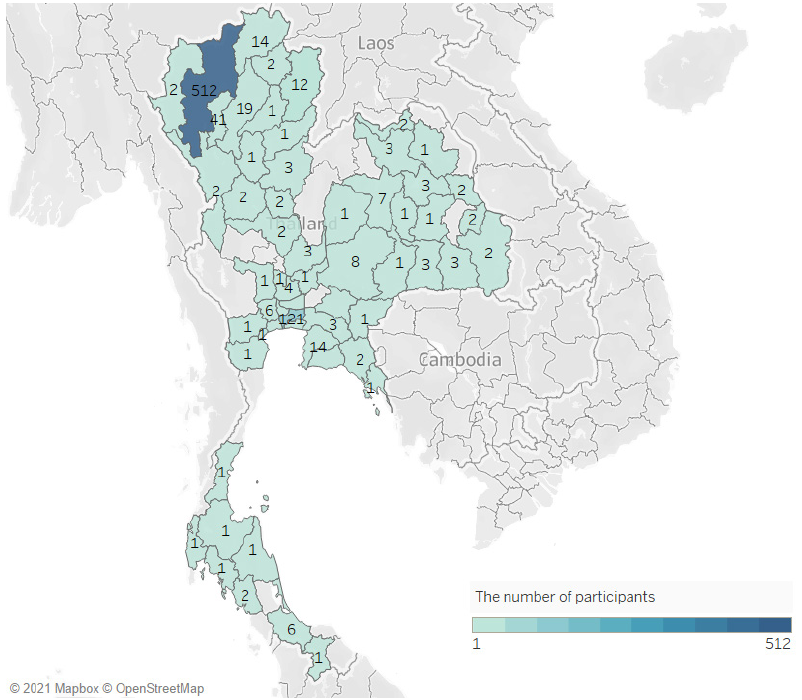
Figure 2. The distribution of survey participants. The figure was created by Tableau Desktop 2021.1, LLC, Seattle, WA, USA.